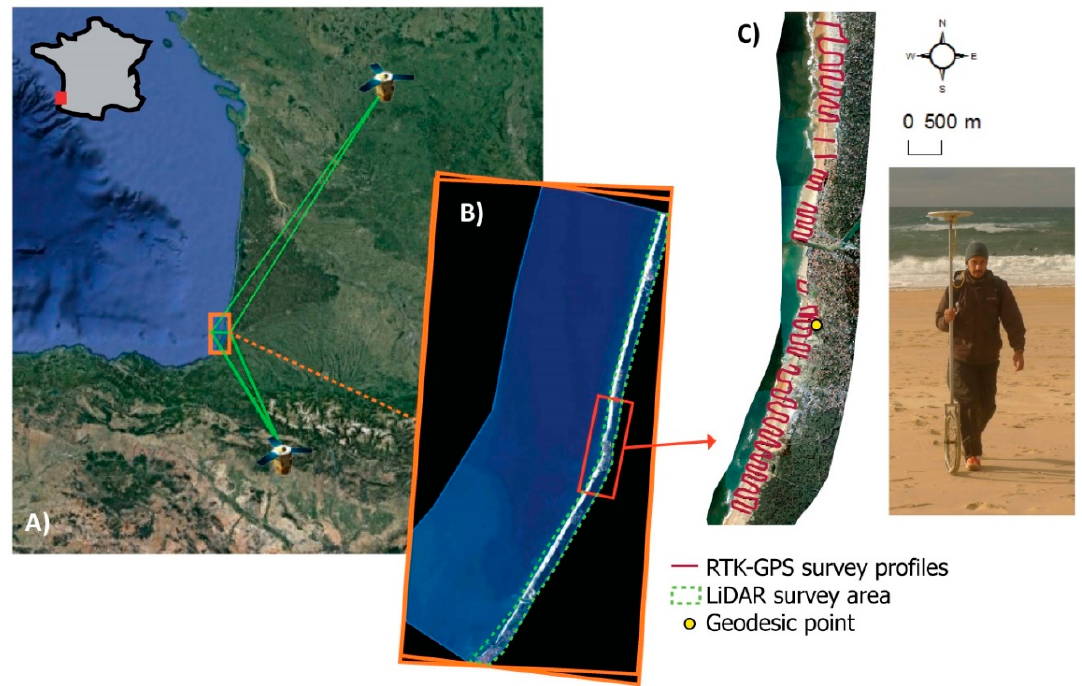
Figure 1. Satellite image of the West of France (source: Google Earth Pro 2018) showing the location where Pleiades stereo ‐ pair was obtained (orange rectangle located in the Southwest of France) on the 14 th of November 2017 ( A ). Zoom in of the Pleiades mosaic showing the area where the airborne ‐ LiDAR topographic survey was performed (polygon with dashed green outline) and the region where RTK ‐ GPS topographic measurements were undertaken ( B ). Panel ( C ) shows the RTK ‐ GPS survey lines (red) and photograph of the surveyor with the GPS rover unit.